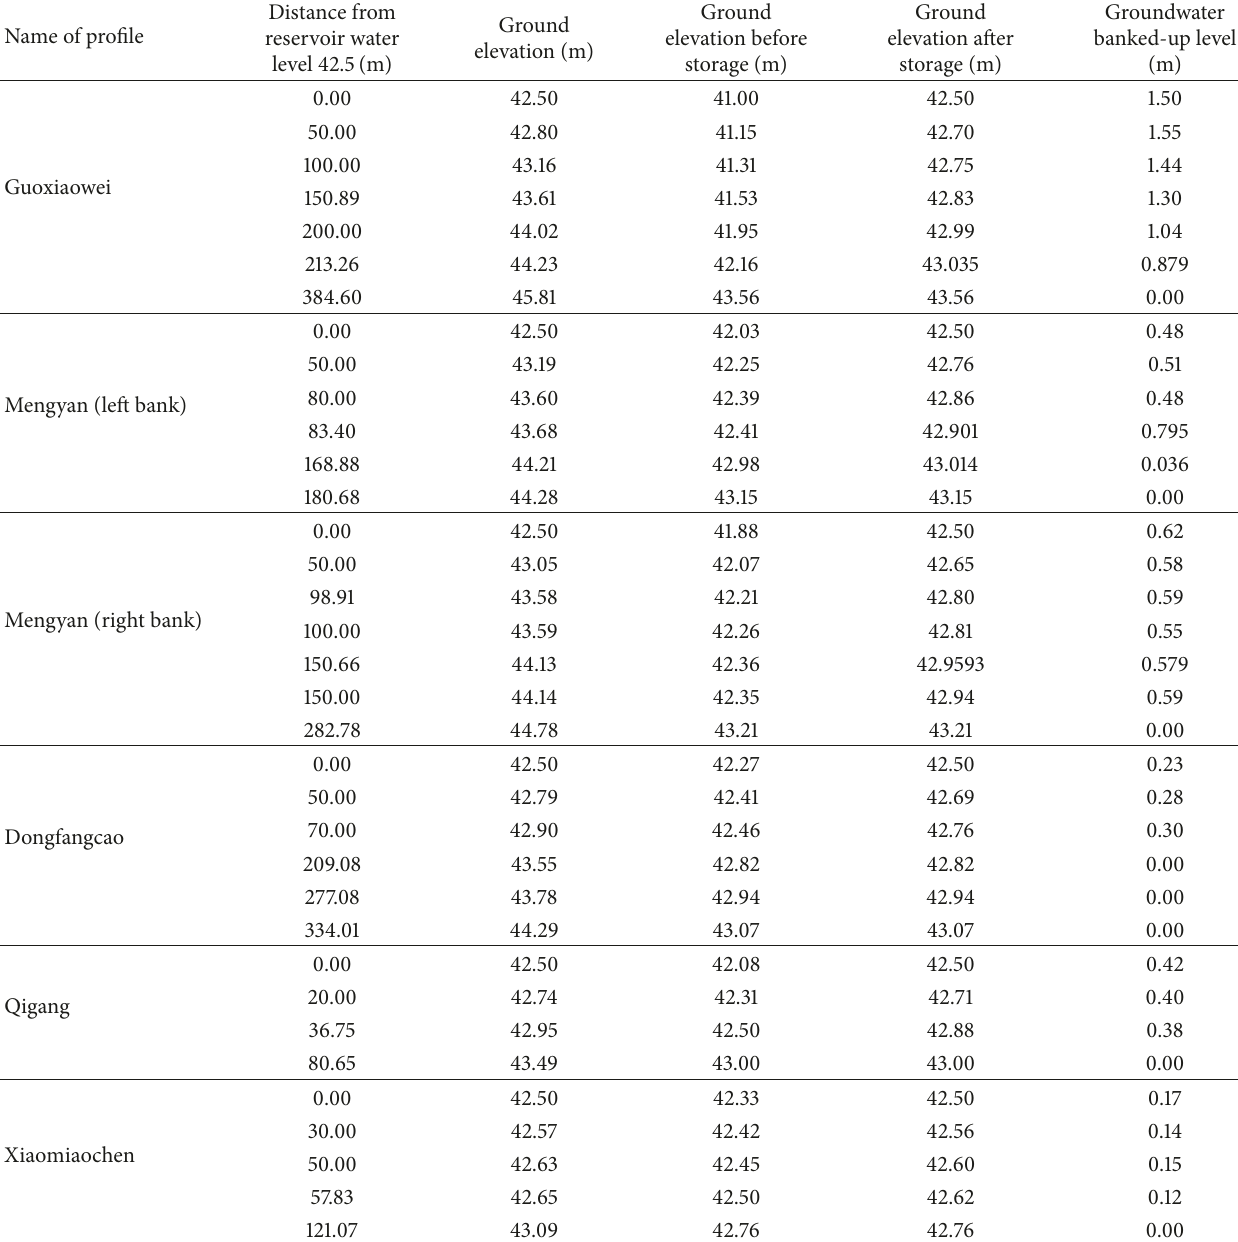
Table 3: Calculation of groundwater banked-up levels at different positions on the bank slope after reservoir impoundment (normal water level: 42.5